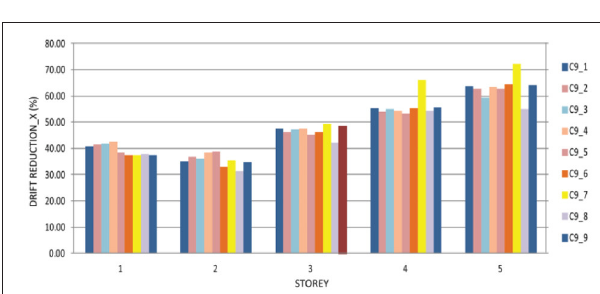
FIGURE 16 | Reduction of the inter story drifts in the case of the structure with the optimal solutions from the ninth cycle compared with the structure without dampers in X